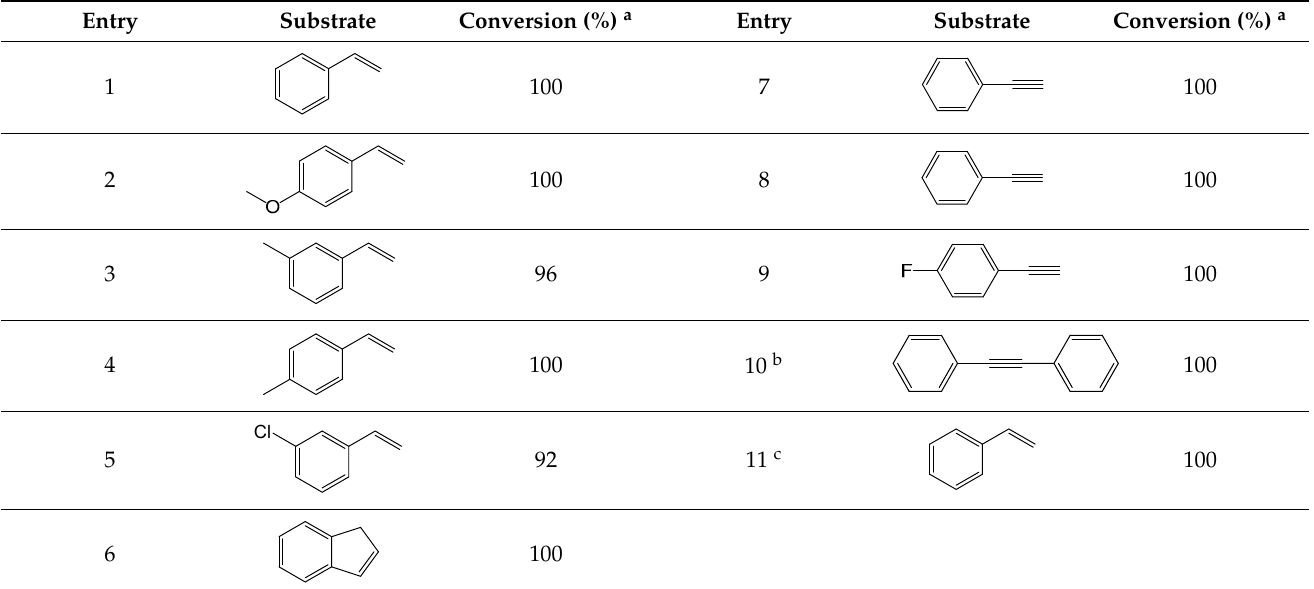
Table 1. The catalytic performance of the Pd NPs /PEG 200 @PU microreactor in the hydrogenation reaction.